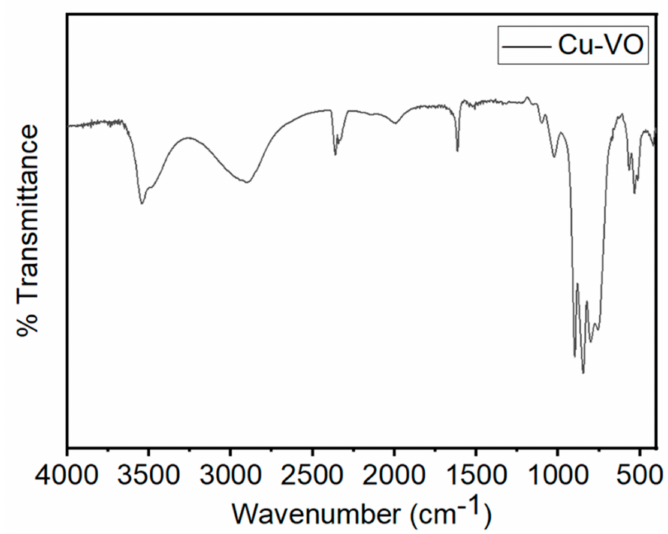
Figure 6. FT-IR spectra of